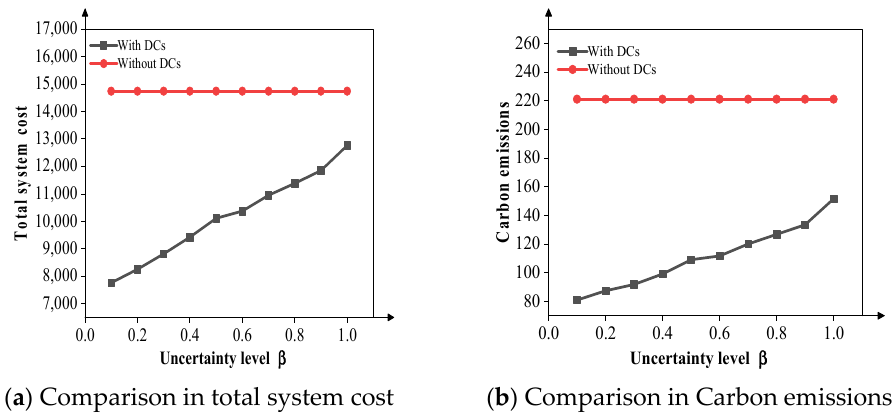
Figure 11. Comparative analyses between without and with DCs considering uncertain